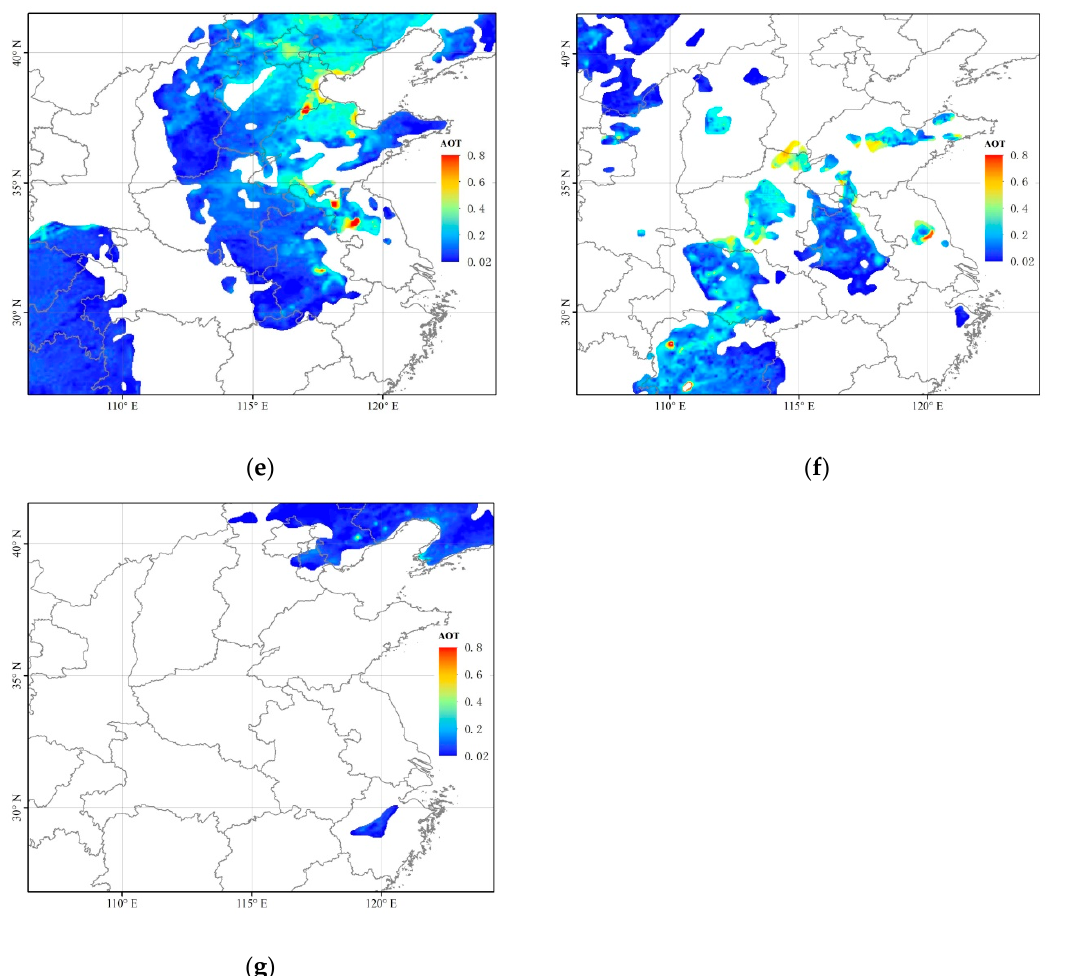
Figure 4. The ground-based PM2.5 concentration measurement over Beijing from 28 October to 6 November.